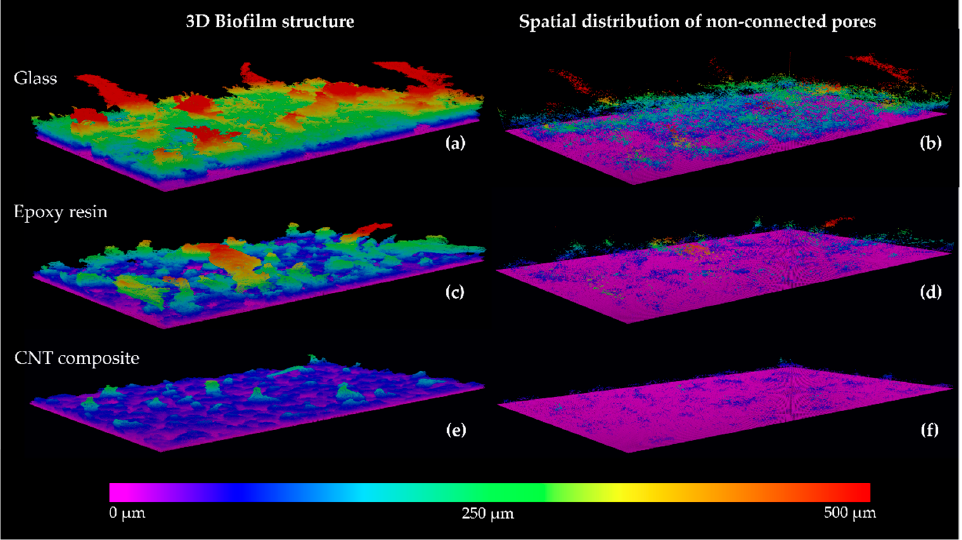
Figure 5. Representative 3D OCT images of Nodosilinea cf. nodulosa LEGE 10377 biofilms formed on glass ( a ), epoxy resin ( c ), and CNT composite ( e ) after 49 days. The spatial distribution of non-connected pores on the biofilm is also shown ( b , d , f ). The color scale shows the distance from the substrate surface.